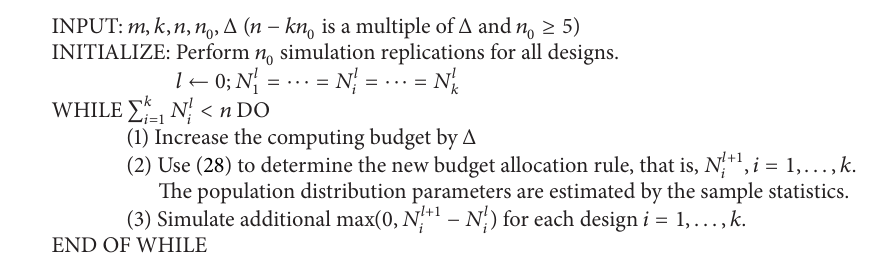
Algorithm 1: Sequential allocation